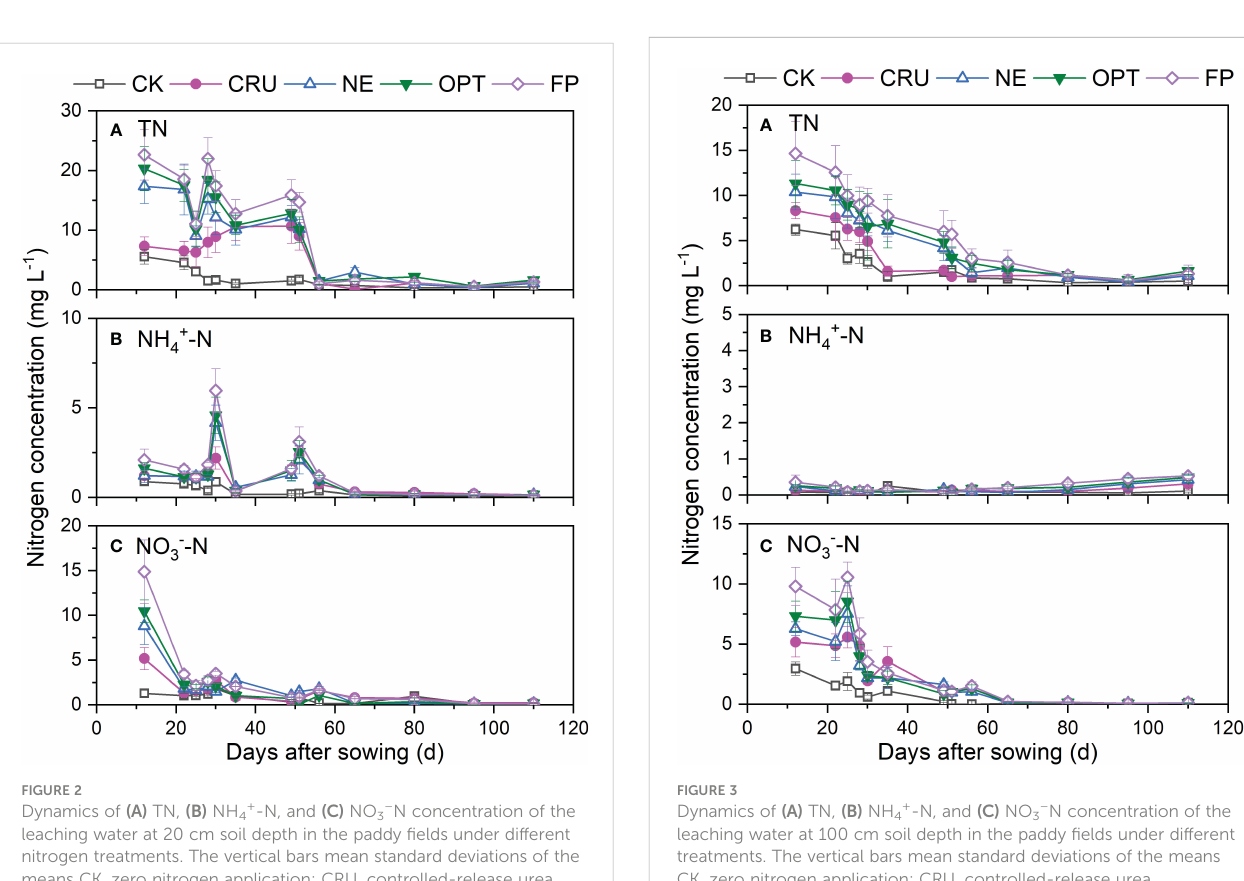
FIGURE 2 Dynamics of (A) TN, (B) NH 4+ -N, and (C) NO 3 – N concentration of the leaching water at 20 cm soil depth in the paddy fi elds under different nitrogen treatments. The vertical bars mean standard deviations of the means CK, zero nitrogen application; CRU, controlled-release urea application; NE, nitrogen expert-based fertilization application strategy; OPT, optimized nitrogen fertilizer application strategy recommended by local government; FP, farmer's experience-based nitrogen fertilizer application strategy.